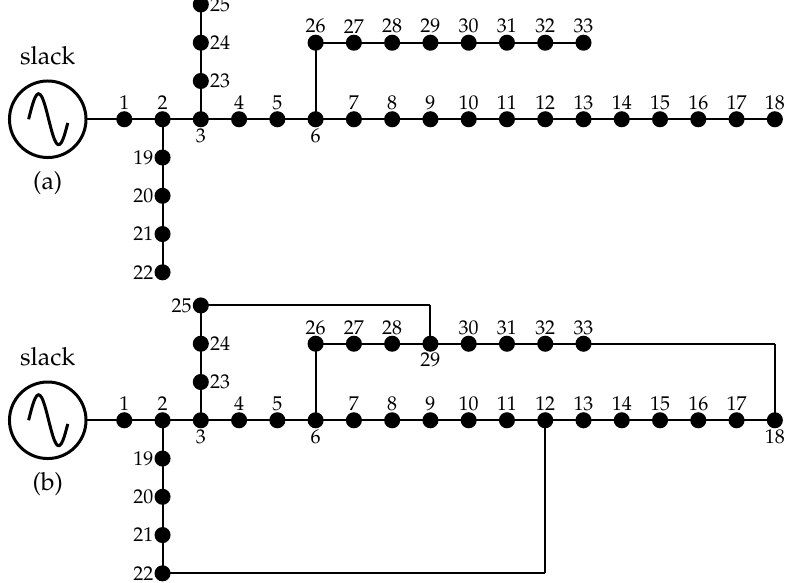
Figure 2. Single line diagrams for the IEEE 33-bus grid: ( a ) radial and ( b ) meshed configurations. Data regarding branches and peak load conditions for the IEEE 33-bus grid are pre- sented in Table 1.